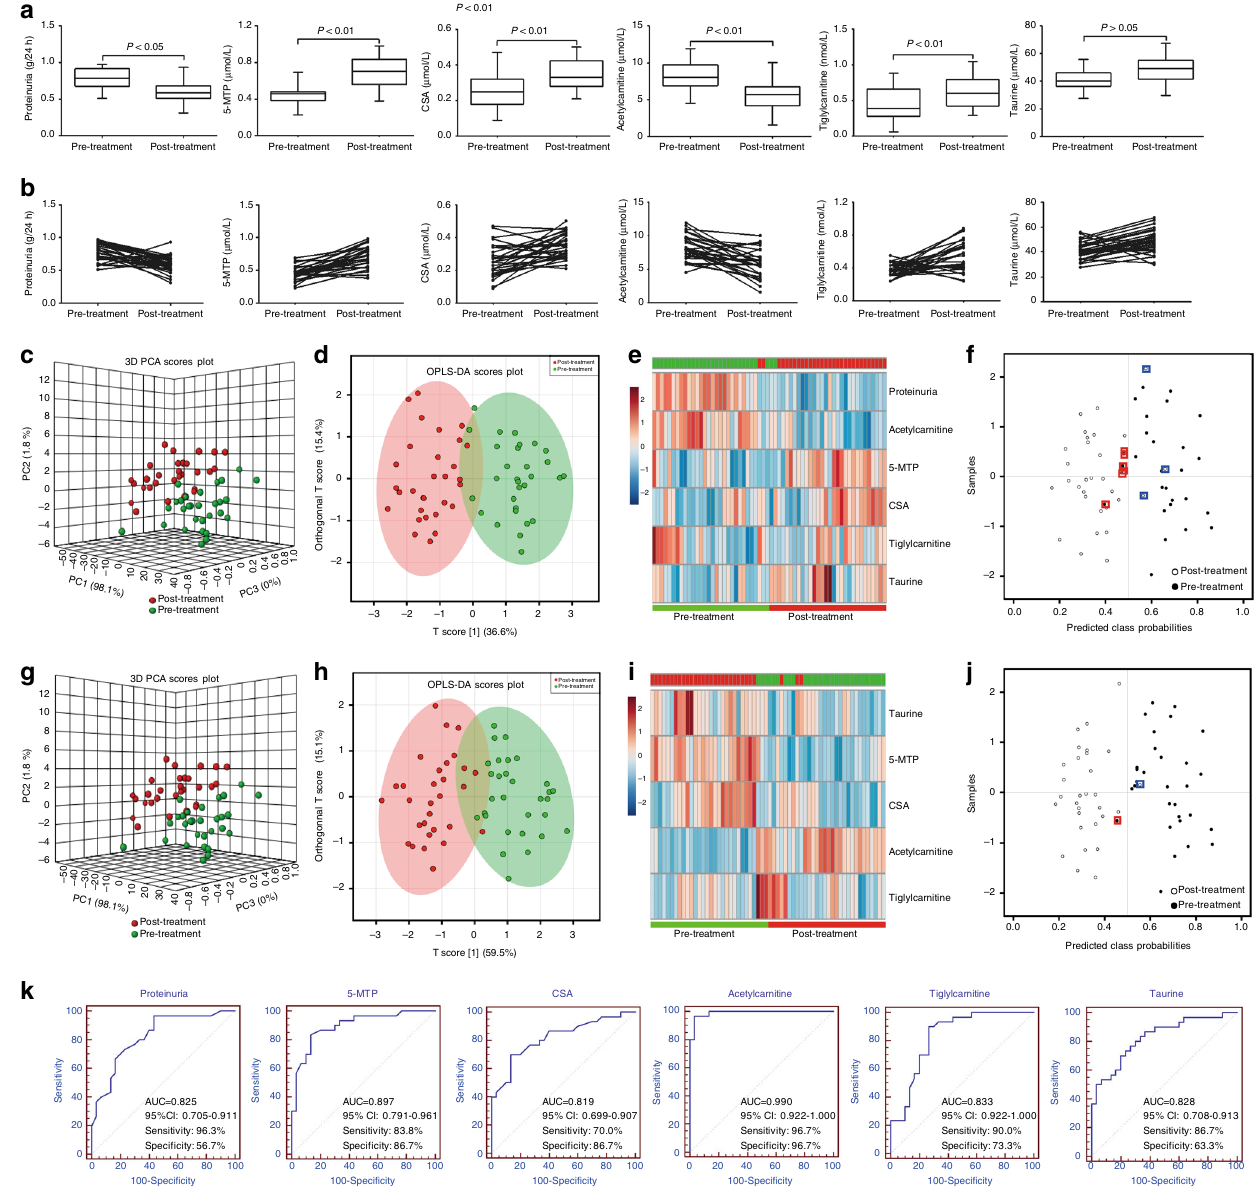
Fig. 4 Five metabolites were further validated in pre- and post-treatment by enalapril. a Box plots of levels of fi ve metabolites including 5-MTP, CSA, acetylcarnitine, tiglylcarnitine and taurine in patients with CKD2 pre- and post-treatment by enalapril. Mean values are presented by horizontal bars. The whiskers indicate the maximum and minimum points. b Dots and lines showing changes of fi ve metabolites in each individual from patients with CKD2 pre- and post-treatment by enalapril. c PCA of two components of proteinuria and fi ve biomarkers. d OPLS-DA of two components of proteinuria and fi ve biomarkers from patients with CKD2 pre- and post-treatment by enalapril. e Heatmap of two components of proteinuria and fi ve biomarkers. f Diagnostic performances of two components of proteinuria and fi ve biomarkers based on the PLS-DA model. The black dots with red squares or black circles with blue squares are for the incorrectly predicted samples in pre- and post-treatment. 24 Out of the 30 patients with CKD2 of pre-treatment were located in pre-treatment area (80.0% speci fi city) and 27 out of the 30 patients with CKD2 of post-treatment were correctly grouped (90.0% sensitivity). g PCA of two components of fi ve biomarkers. h OPLS-DA of fi ve biomarkers. i Heatmap of fi ve biomarkers. j Diagnostic performances of fi ve biomarkers based on the PLS-DA model. The black dots with red squares and or black circles with blue squares are for the incorrectly predicted samples in pre- and post-treatment. 29 Out of the 30 patients with CKD2 of pre-treatment were located in pre-treatment area (96.7% speci fi city) and 29 out of the 30 patients with CKD2 of post-treatment were correctly grouped (96.7% sensitivity). These results demonstrated that the fi ve biomarkers show high prediction class probabilities. k Analysis of PLS-DA based ROC curves of proteinuria and fi ve metabolites in patients with CKD2 pre- and post-treatment by enalapril. The associated AUC, 95% con fi dence interval (CI), sensitivity and speci fi city values were indicated. Student ’ s t test was used for the signi fi cance of difference between two